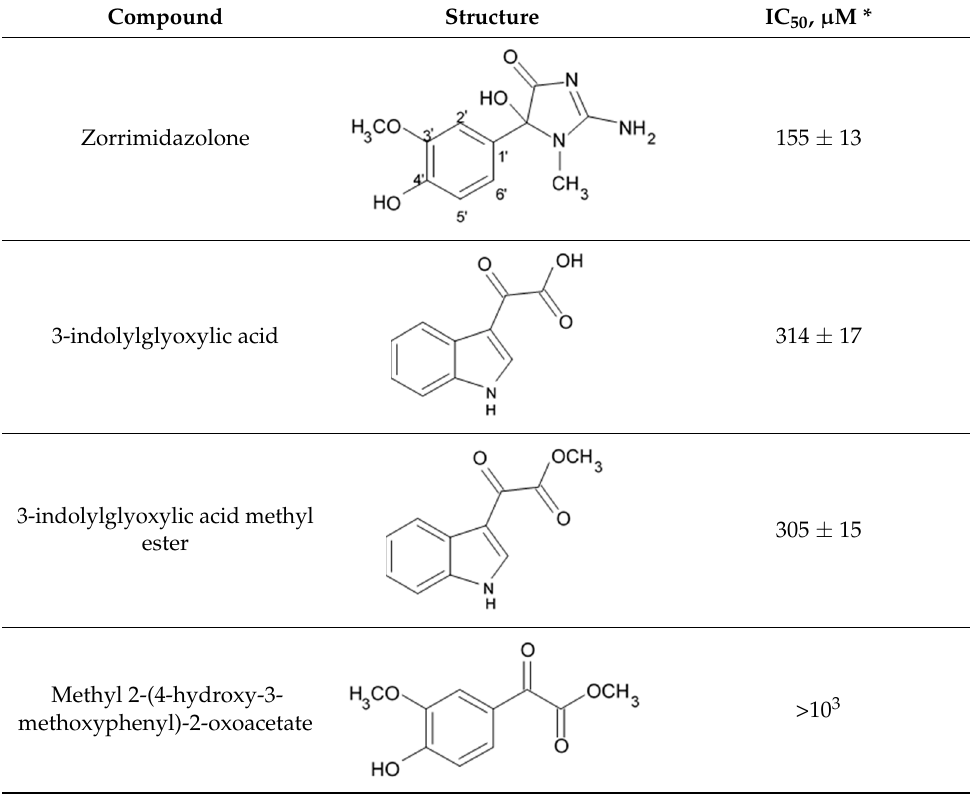
Table 1. Structure and inhibitory activity of marine metabolites from ascidian Polyandrocarpa zorritensis against glioma C6 line [39].